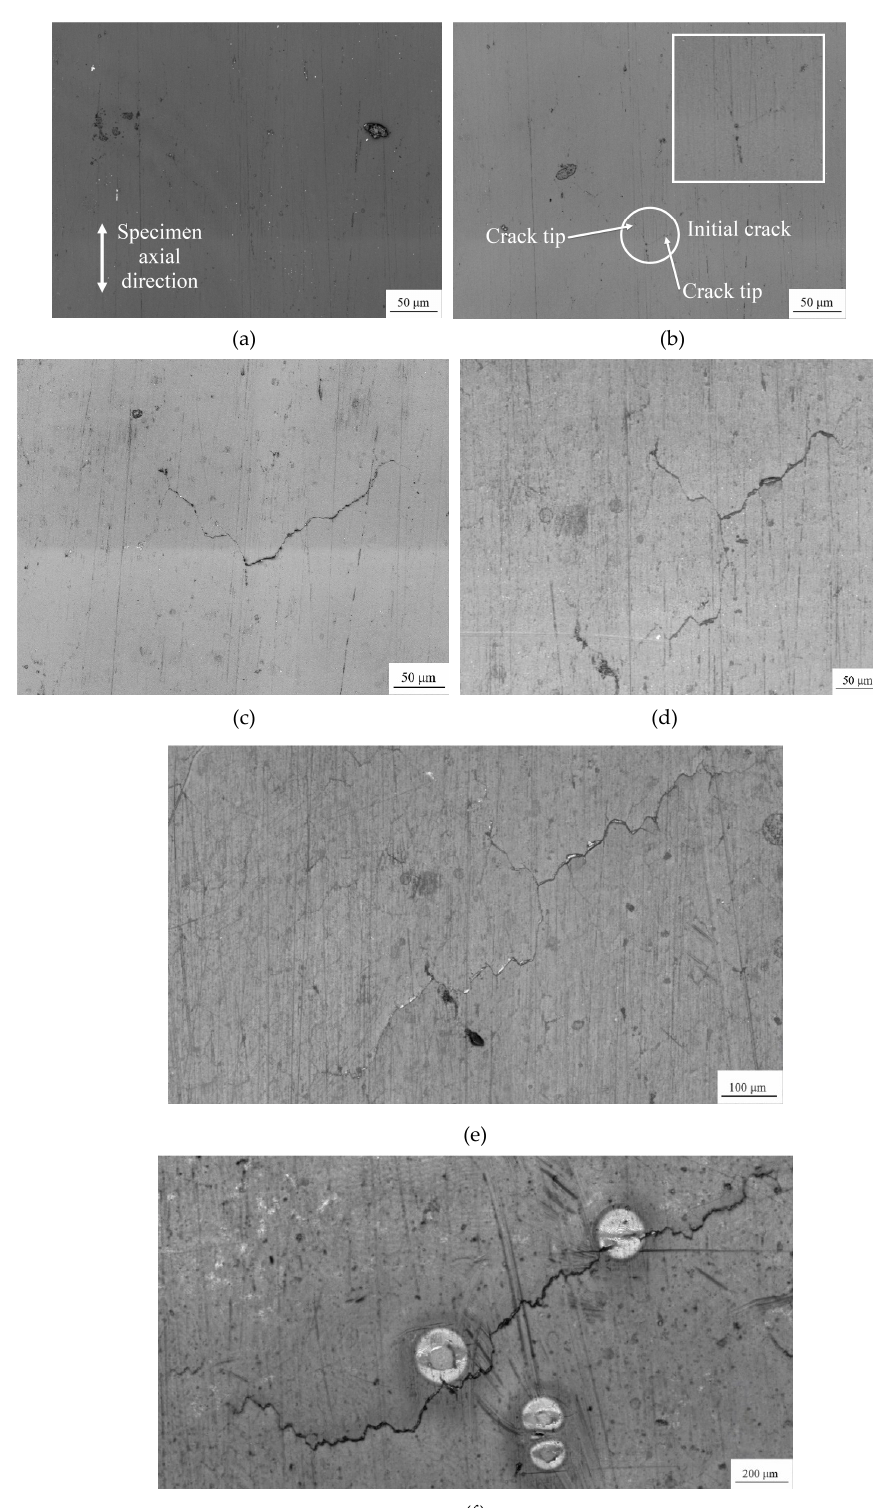
(g) Figure 4. Replica photos for specimen TC2 under different number of cycles: ( a ) N = 0 cycles; ( b ) N = 200 cycles; ( c ) N = 4,000 cycles; ( d ) N = 14,000 cycles; ( e ) N = 30,000 cycles; ( f ) N = 53,000 cycles; ( g ) N = 59,000 cycles.